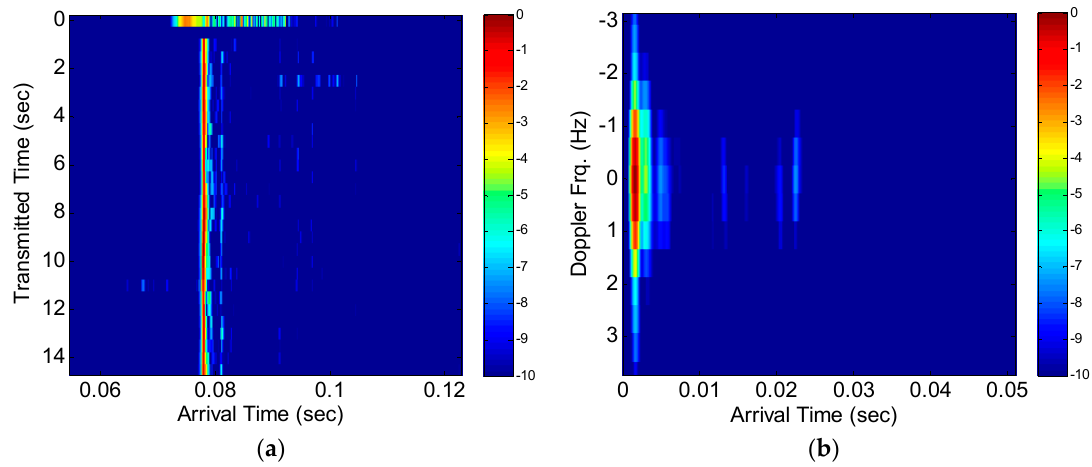
Figure 4. Underwater experimental environment: ( a ) CIR (Channel Impulse Response); ( b ) scattering function.